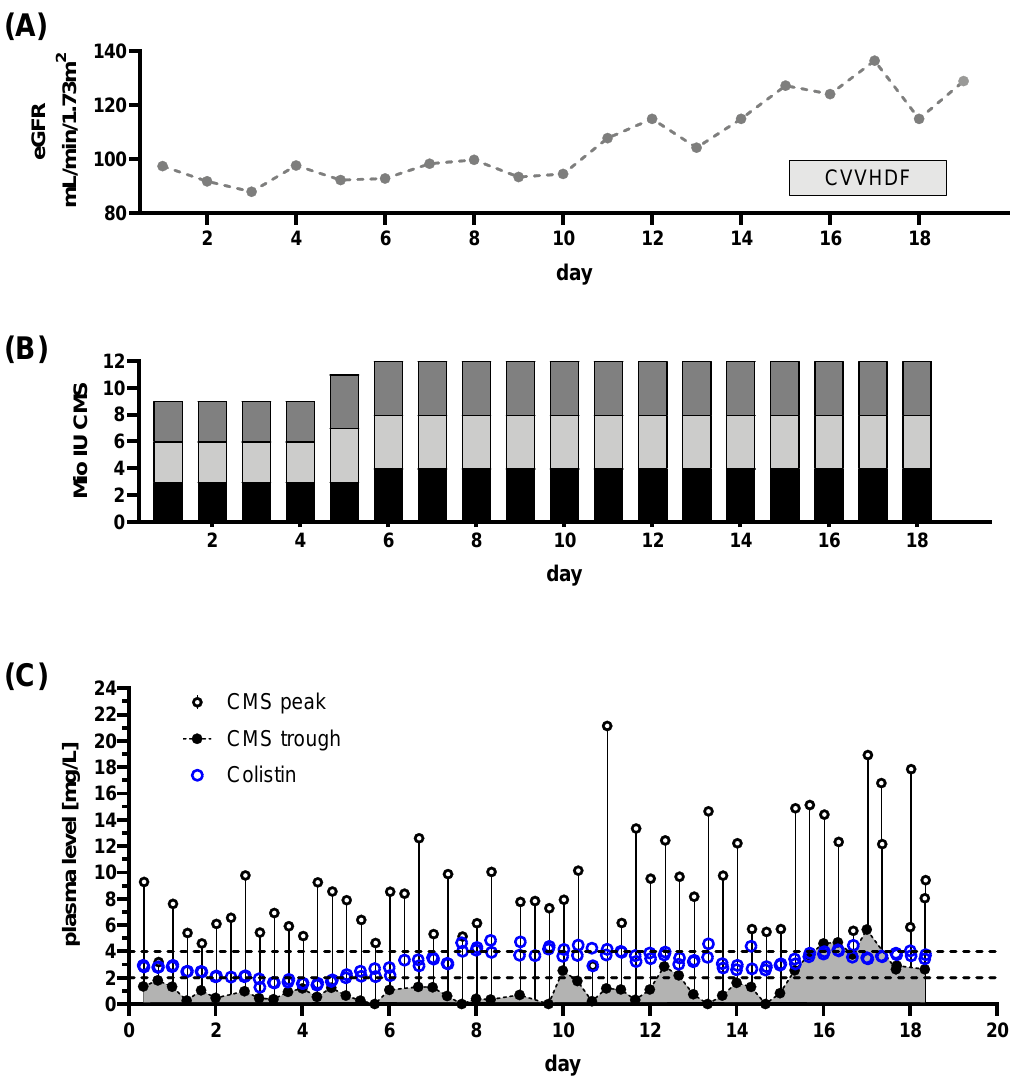
Figure 5. Renal function, dose regimen and drug plasma levels of patient 3: a total of 105 samples were analyzed (colisthimethate sodium (CMS) peak n = 56, CMS trough n = 50, Colistin peak n = 54, Colistin trough n = 51). ( A ) estimated glomerular filtration rate (eGFR) derived from serum creatinine levels and renal replacement therapy via continuous venovenous hemodiafiltration (CVVHDF). ( B ) Dose regimen used. Shaded blocks depict the particular individual doses each day. ( C ) Time course of CMS trough and peak levels along with Colistin levels. The CMS reservoir is indicated by the area gray shaded portion of panel ( C ). Target range for Colistin plasma levels is indicated by dashed lines.